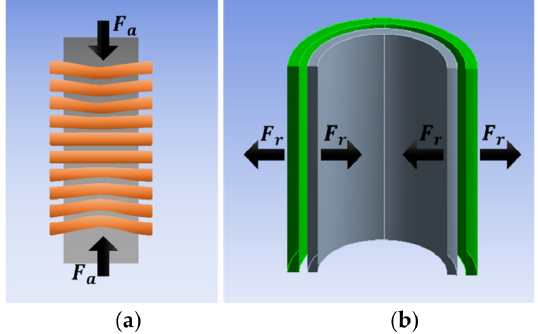
Figure 3. Behavior of forces in the transformer winding: ( a ) axial, ( b )